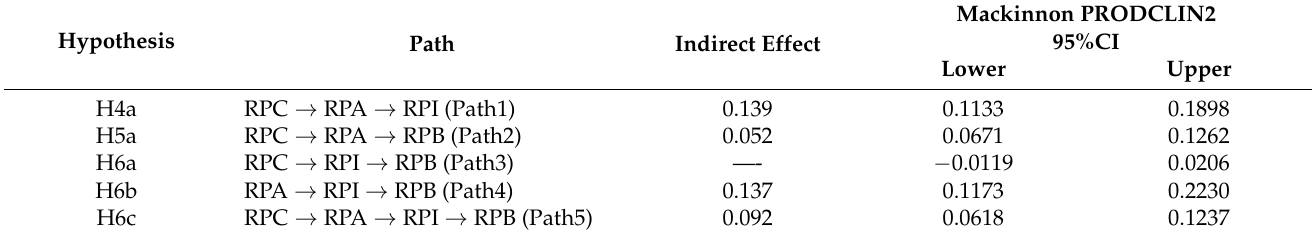
Table 4. Results of the mediation